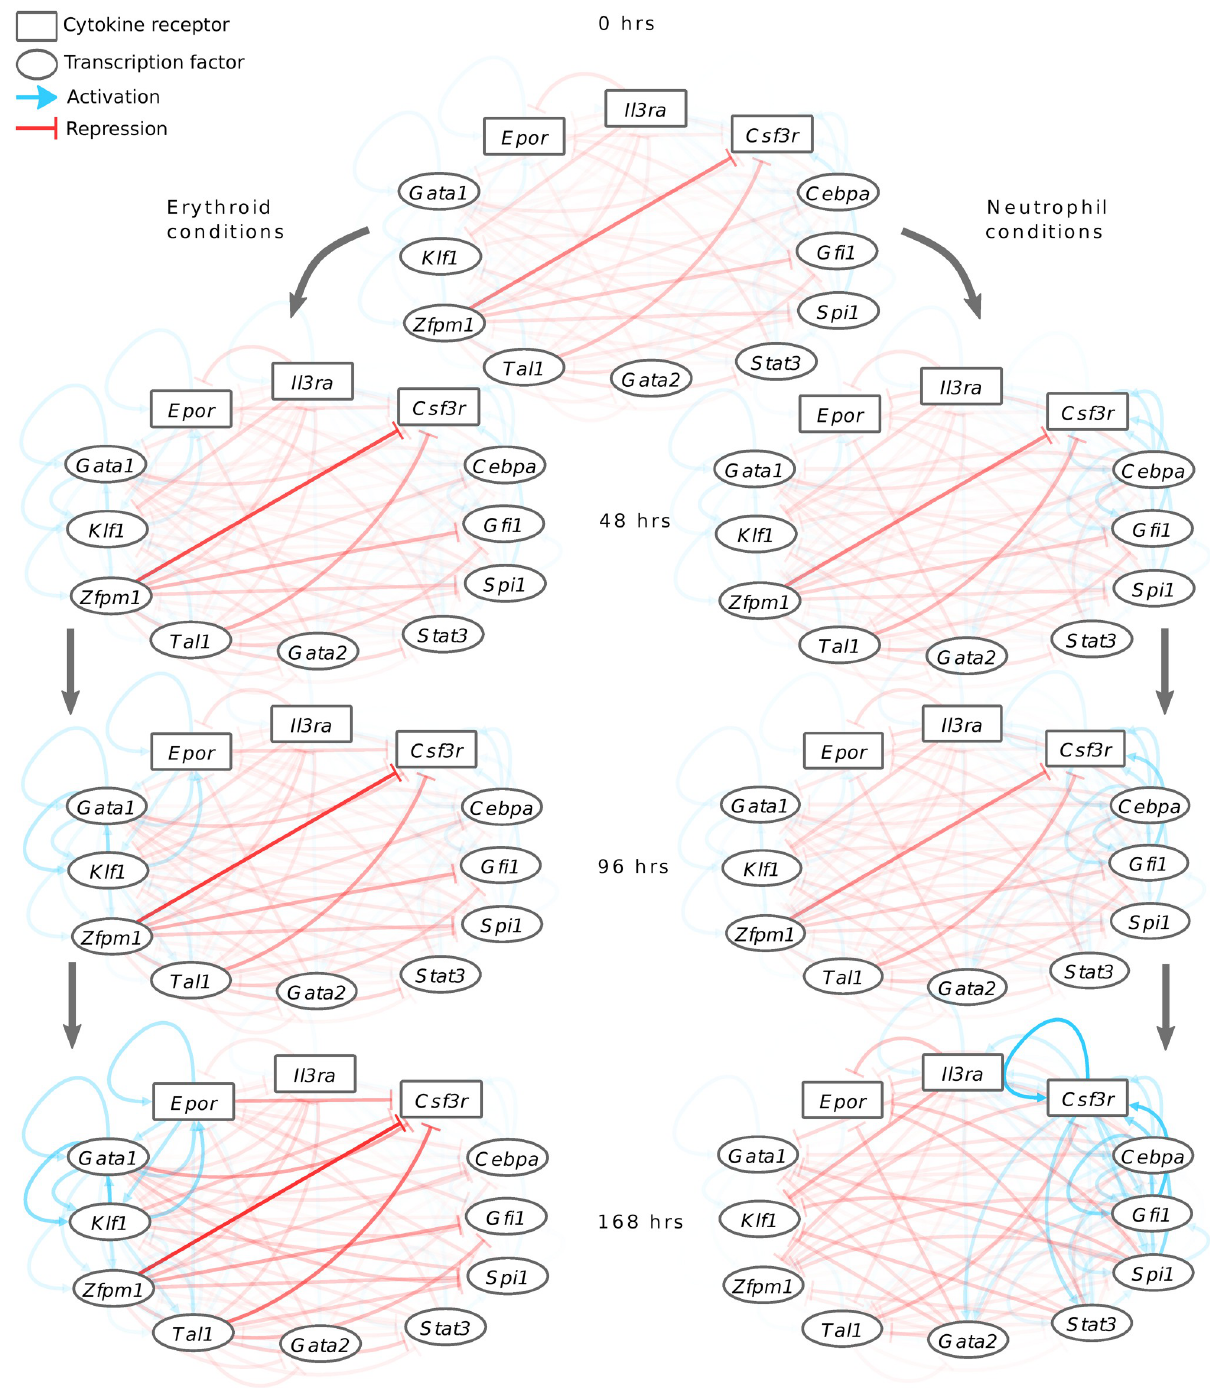
Fig 5. The time evolution of the inferred GRN. The GRN is depicted as a graph at different time points during differentiation in both erythrocyte and neutrophil conditions. The contributions of each regulator to the regulation of its targets, given by the product of the pairwise genetic interconnectivity parameter and the regulator’s concentration, are shown as edges from the regulator to the targets. Blue and red edges correspond to activation and repression respectively, while the opacity of the lines indicates the strength of regulation. The maximum opacities of activation and repression have been normalized to 1